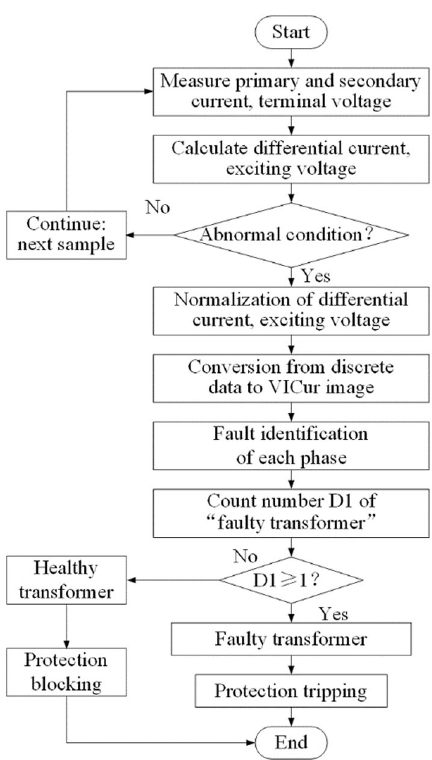
Fig. 5 Logic diagram of transformer protection scheme Fig. 6 Model of simulations and